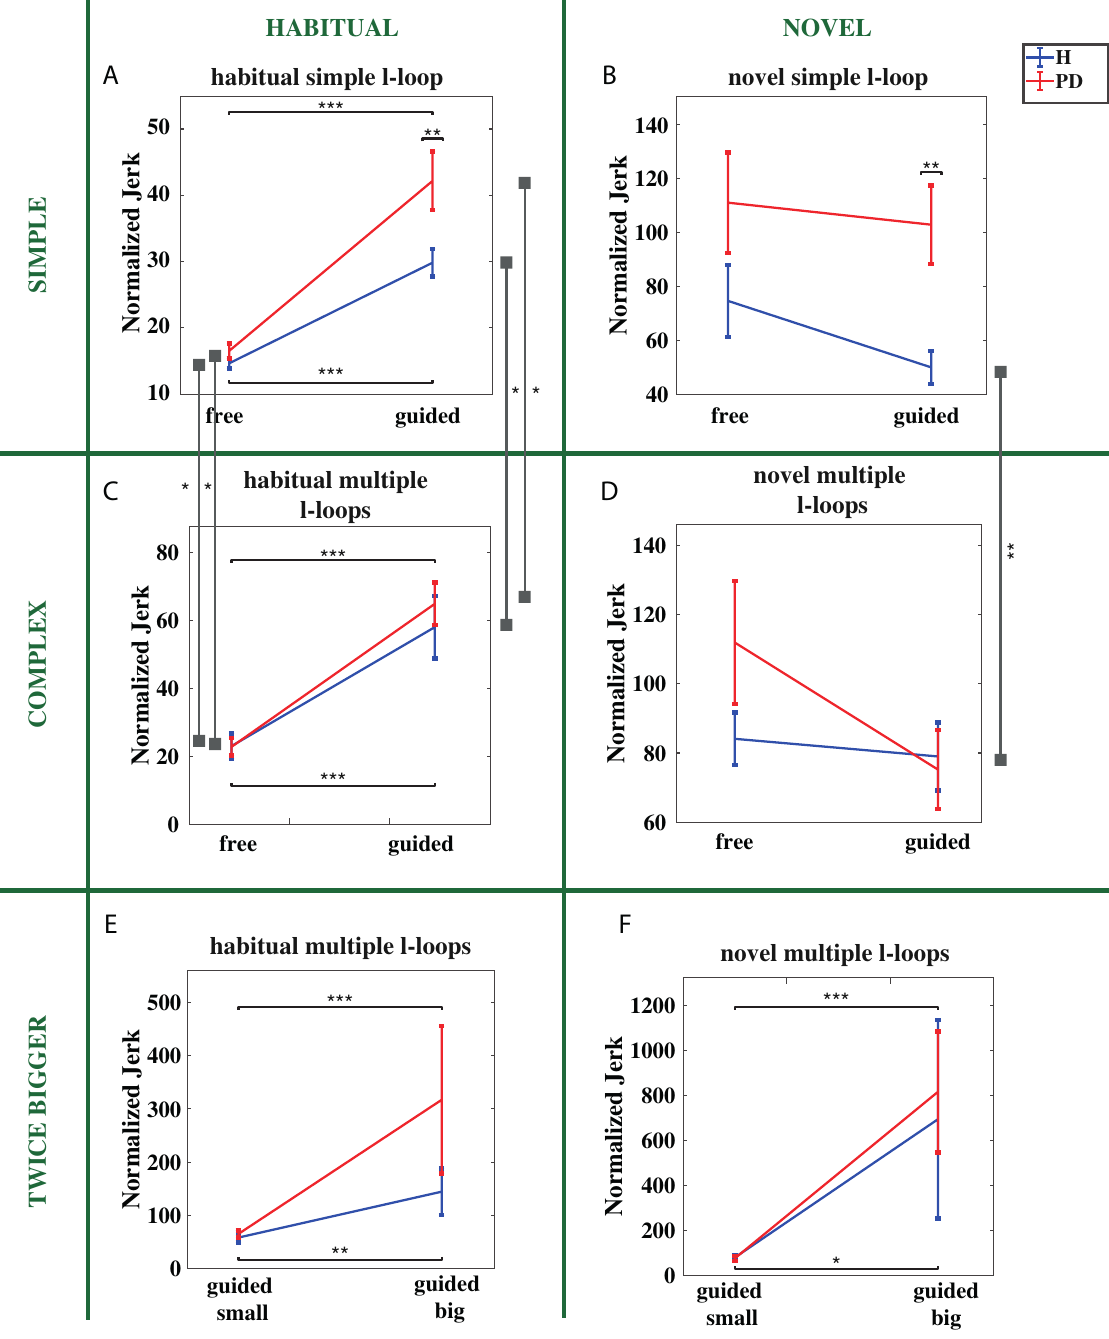
Figure 6. Normalized Jerk (mean ± SEM) across PD patients (red lines) and H subjects (blue lines) for all conditions: ( A ) Habitual simple l-loop, ( B ) Novel simple l-loop, ( C ) Habitual multiple l-loops, ( D ) Novel multiple l-loops, ( E ) Habitual multiple l-loops, ( F ) Novel multiple l-loops. Grey and black lines indicate the results of t -tests that gave significant differences. Stars indicate the results of one-tailed t -tests corrected with the FDR procedure (* p < 0.05; ** p < 0.01; *** p <